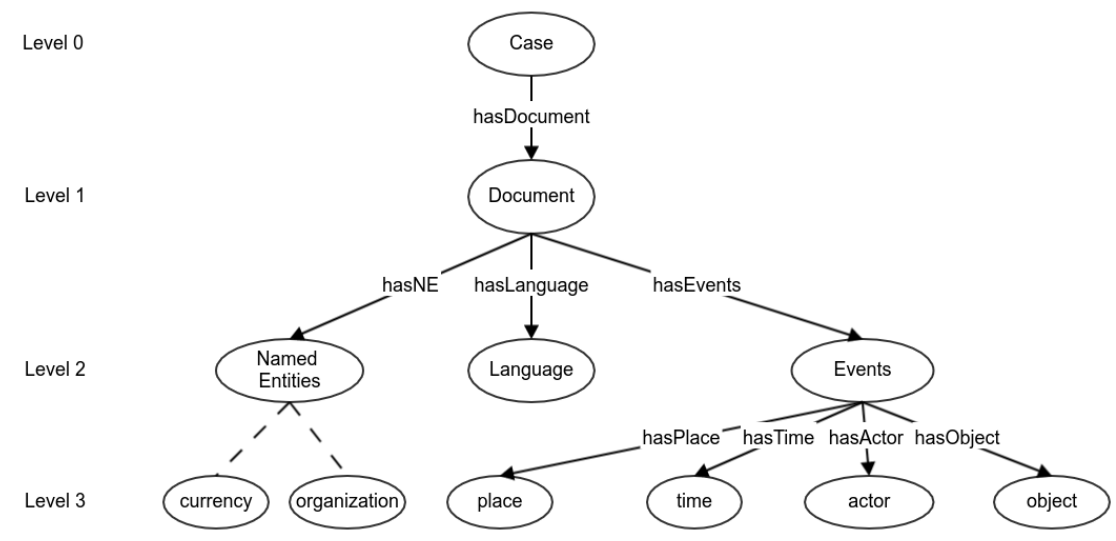
Figure 2. Ontology Diagram.